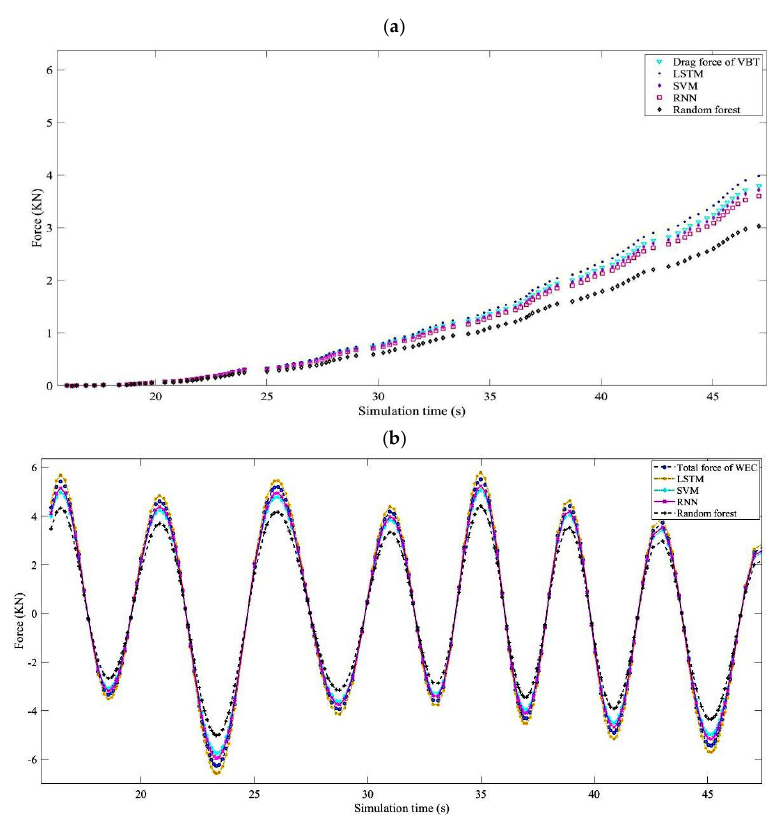
Figure 3. Forces over 50 s of simulation for ( a ) VBT and ( b ) WEC.